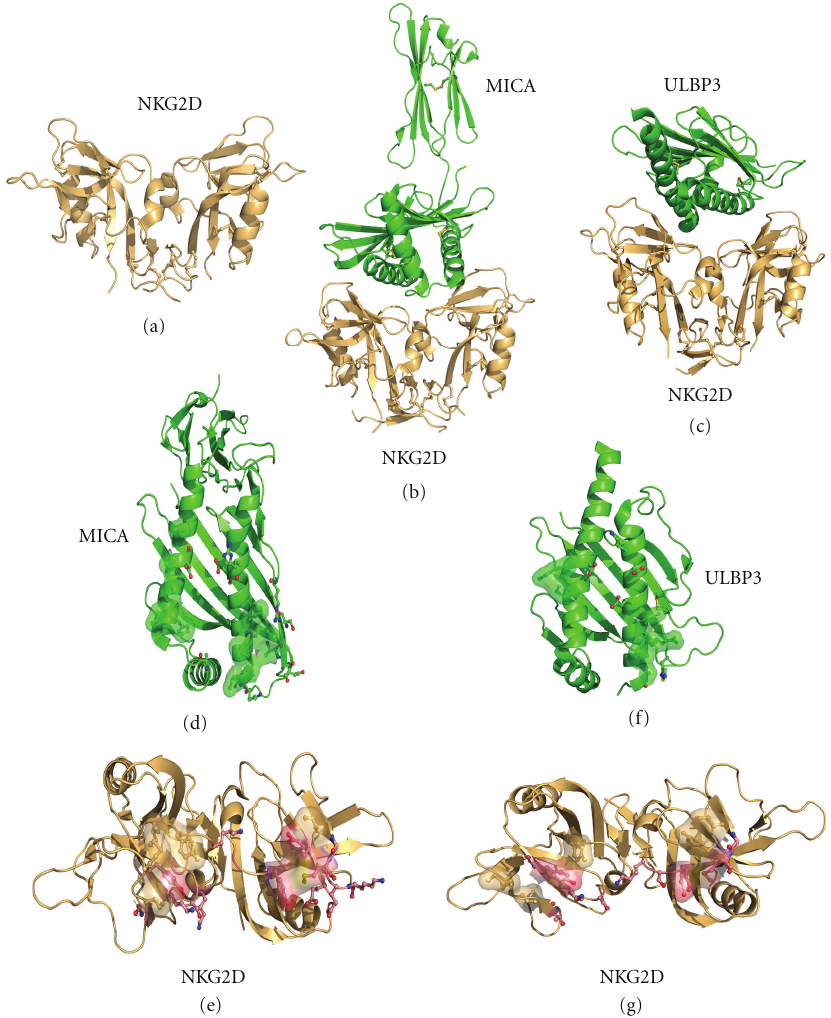
Figure 8: Structure of NKG2D homodimer and associated complexes. (a) NKG2D homodimeric structure. (b) NKG2D in the same orientation as (a) in complex with the two domain MICA molecule. (c) NKG2D in complex with ULBP3. (d) MICA structure rotated 90 ◦ in orientation relative to (b); residues forming hydrogen bonds with NKG2D are shown in ball and stick representation with red carbon and blue nitrogen atoms while residues forming hydrophobic interactions are shown in yellow transparent surface representation. (e) NKG2D structure rotated 90 ◦ in orientation relative to (b); residues forming hydrogen bonds with MICA are shown in ball and stick representation with red carbon and blue nitrogen atoms while residues forming hydrophobic interactions are shown in green transparent surface representation. (f) ULBP3 structure rotated 90 ◦ in orientation relative to (c); residues forming hydrogen bonds with NKG2D are shown in ball and stick representation with red carbon and blue nitrogen atoms while residues forming hydrophobic interactions are shown in yellow transparent surface representation. (g) NKG2D structure rotated 90 ◦ in orientation relative to (b); residues forming hydrogen bonds with ULBP3 are shown in ball and stick representation with red carbon and blue nitrogen atoms while residues forming hydrophobic interactions are shown in green transparent surface